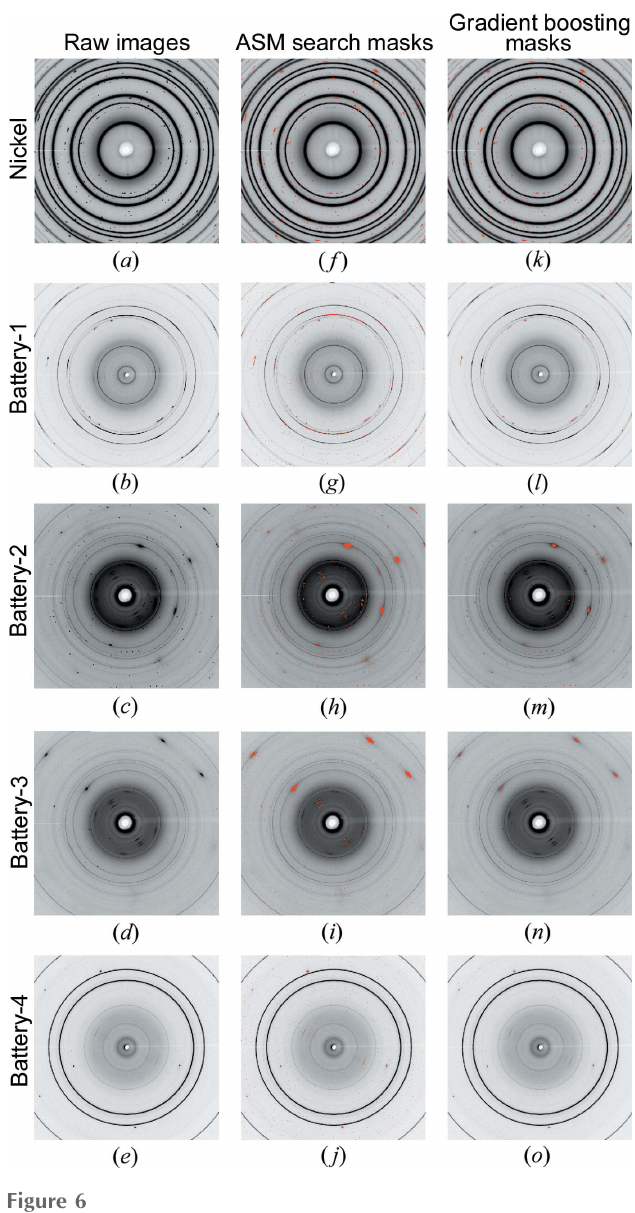
Figure 6 Qualitative masking results. ( a )–( e ) Raw images. ( f )–( j ) Results of masking using the ASM search. ( k )–( o ) Results of masking using the gradient boosting method. Each row consists of images that belong to the Nickel, Battery-1, Battery-2, Battery-3 or Battery-4 datasets, respectively, from top to